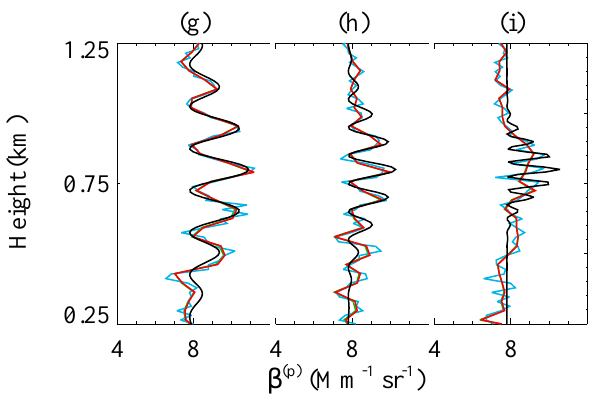
Fig. 6. A closer examination of cases (g–i) of Fig. 5, highlighting how the coarse retrievals fail to capture the smallest features and that all resolutions tend to smooth the magnitude of the peaks.